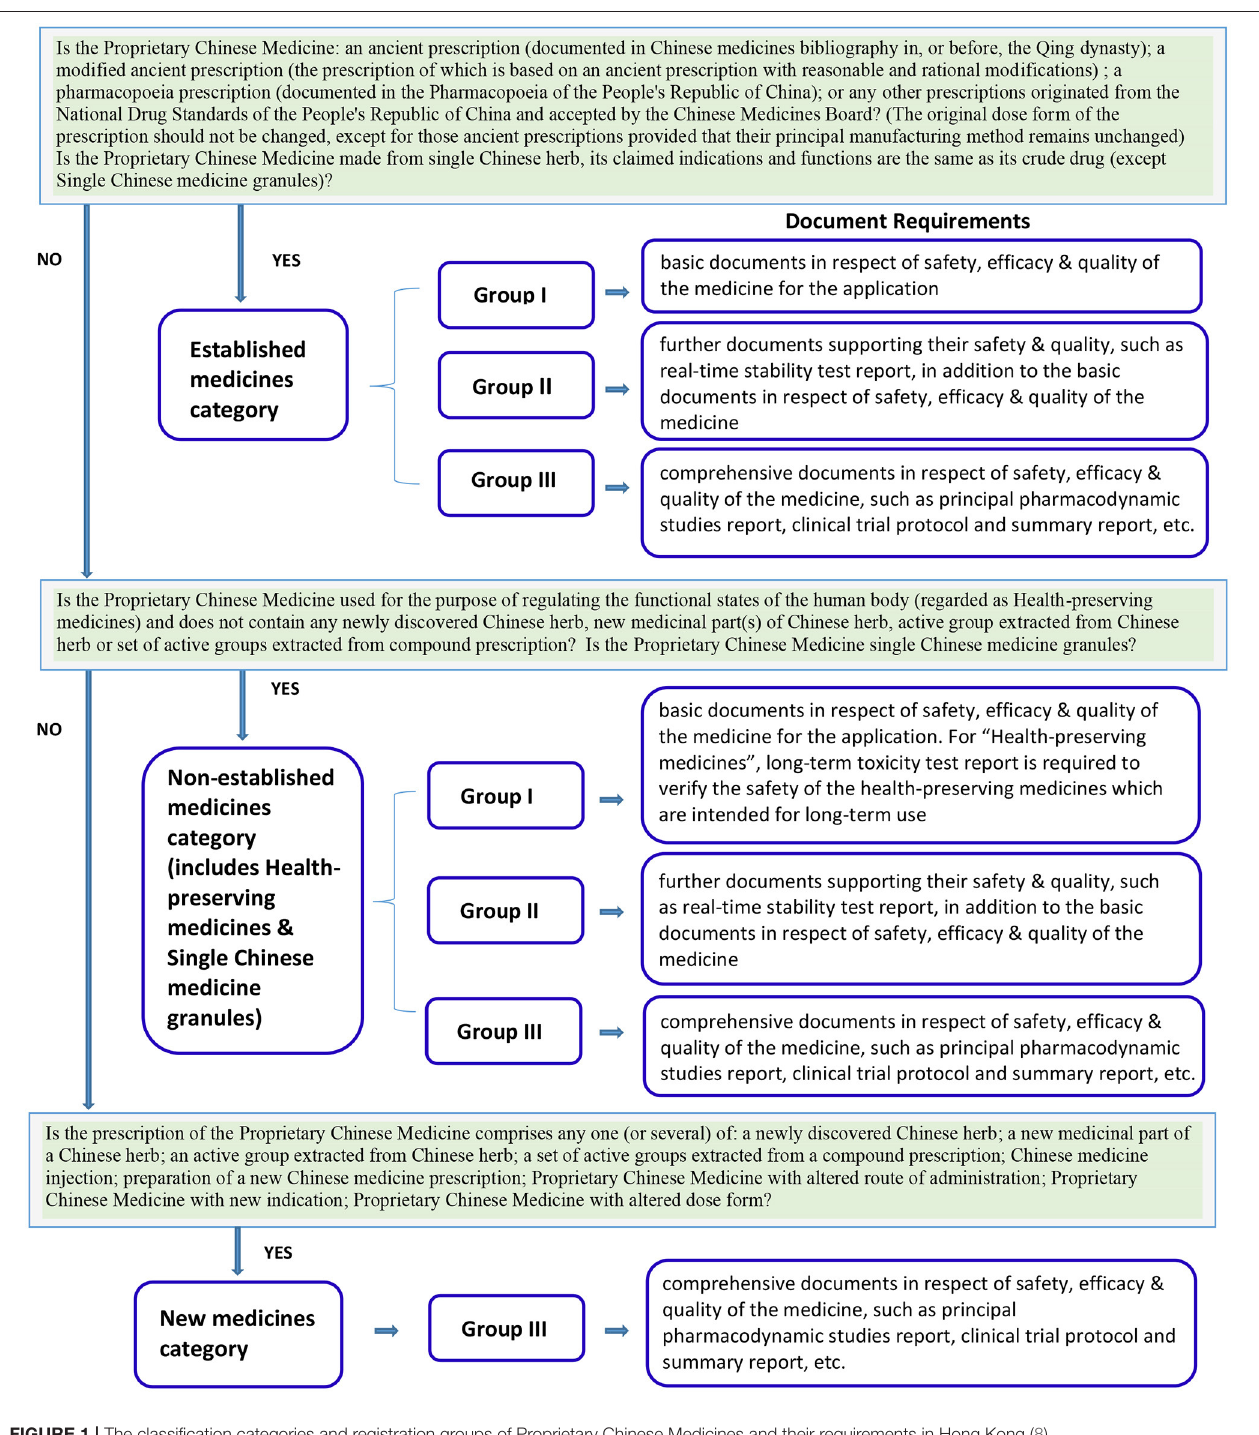
acids and many different traditional medicines including most Proprietary Chinese Medicine. Proprietary Chinese Medicine can be registered under a Class I or Class II or Class III product license (9) (see Figure 2 ). For example, Proprietary Chinese